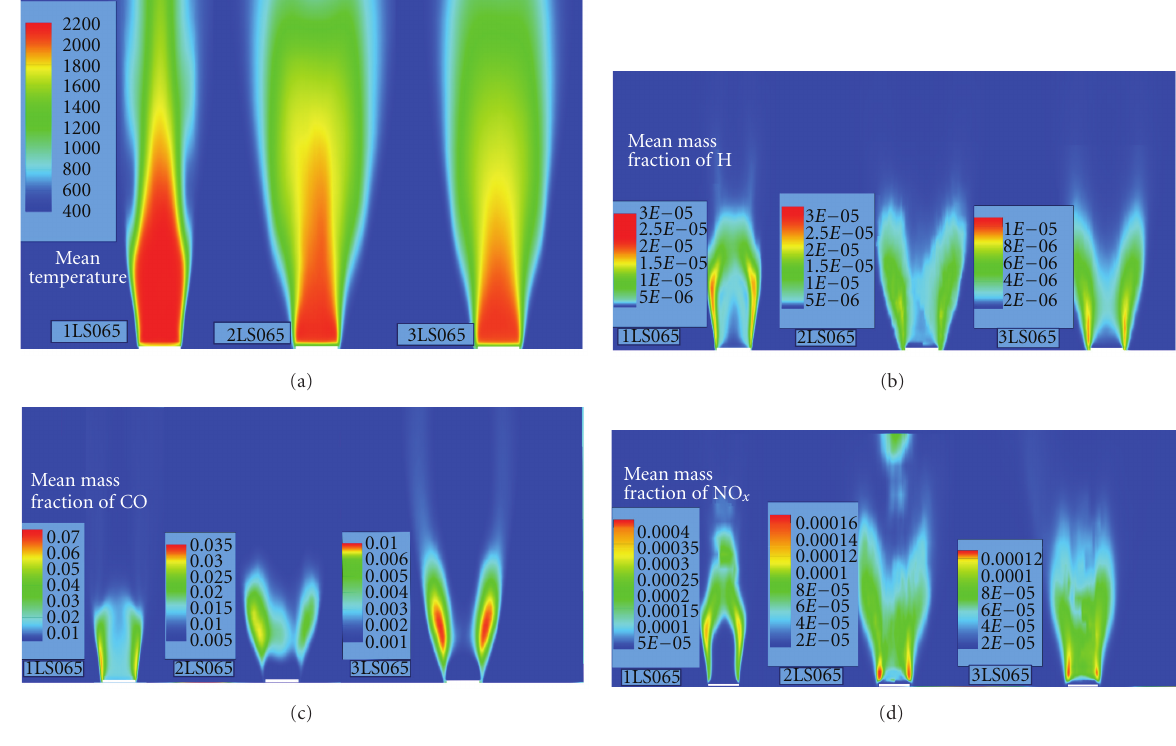
Figure 9: Simulated mean wake topologies for the three burner configurations, mean temperature (a) and mean mass fractions of radical H (b), CO (c) and NO x (d).